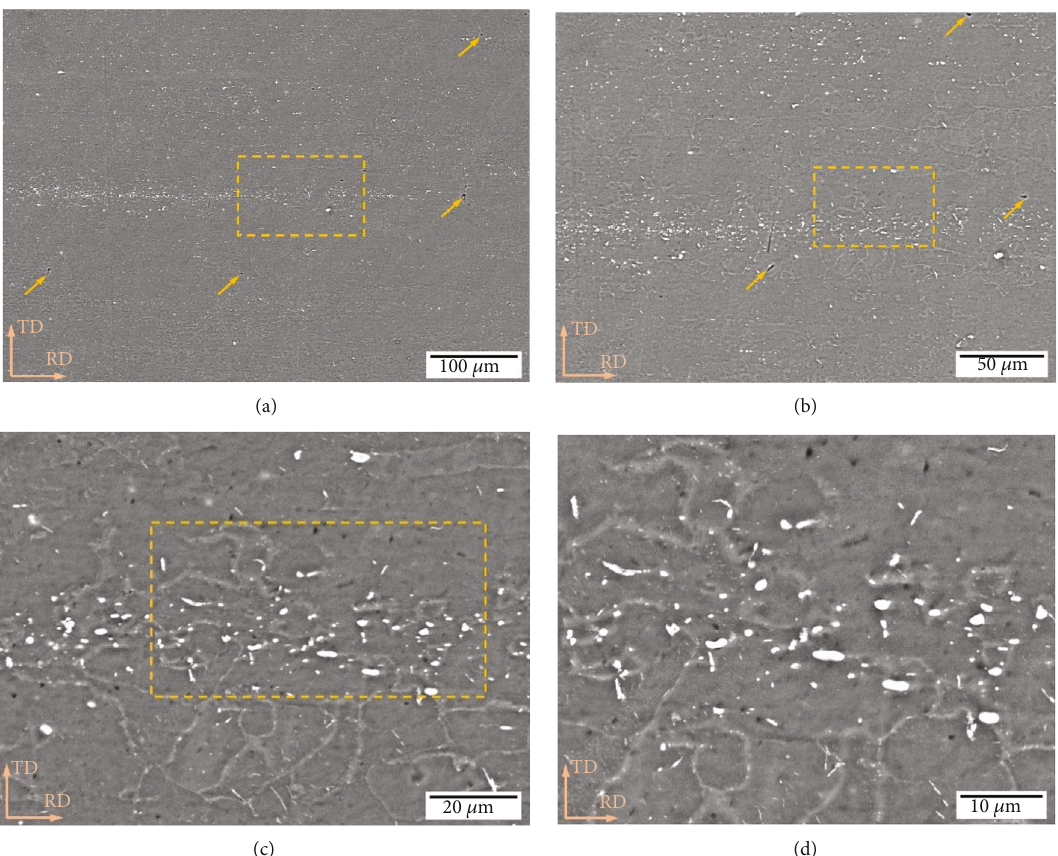
Figure 3: BSE micrographs of 2195-T8 alloy: (a) 500x magni fi cation; (b) 1,000x magni fi cation of the dotted frame in (a); (c) 3,000x magni fi cation of the dotted frame in (b); (d) 5,000x magni fi cation of the dotted frame in